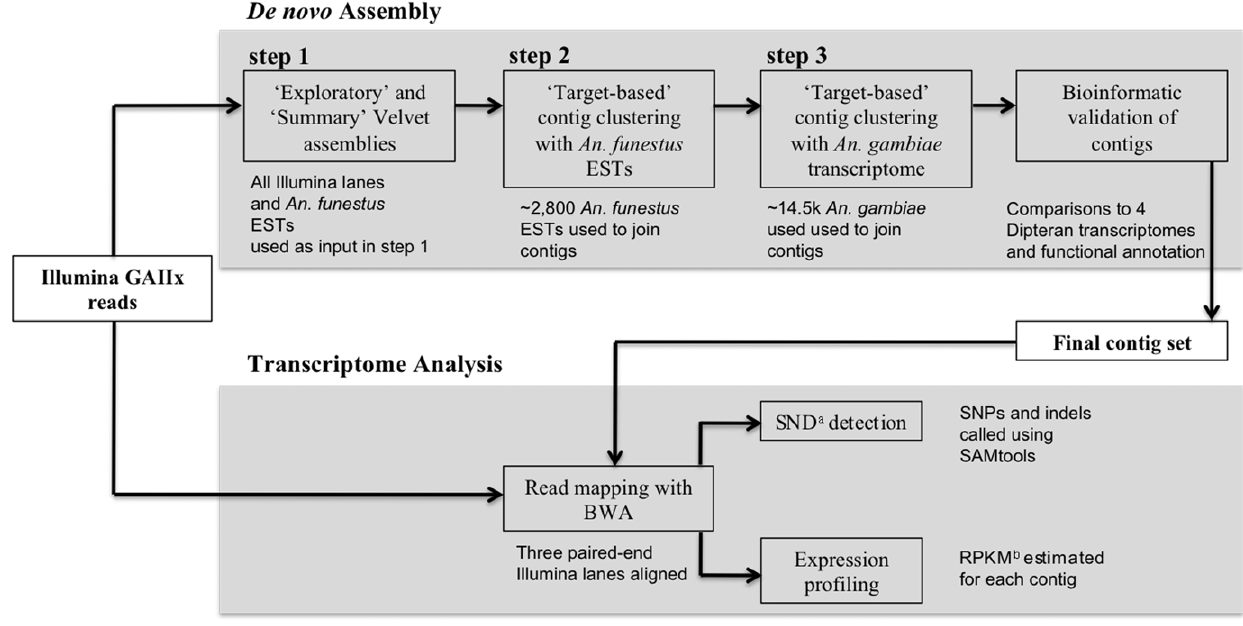
Figure 1. De novo transcriptome assembly and analysis workflow. Illumina reads were assembled in a series of ‘exploratory’ Velvet assemblies, the contig output of which was used in a ‘summary’ assembly. Following iterative assembly with Velvet, contigs were clustered and joined when possible, first using conspecific ESTs, then using the transcriptome of a closely related species. A final contig set was generated by selecting contigs based on bioinformatic support criteria. Illumina reads were then mapped to the final contig set and resulting alignments were used for expression profiling and polymorphism discovery. a SND refers to short nucleotide discrepancies including both single nucleotide polymorphisms and indels. b RPKM, or reads per kilobase per million mapped reads [40], was calculated for each contig and used to represent expression level.